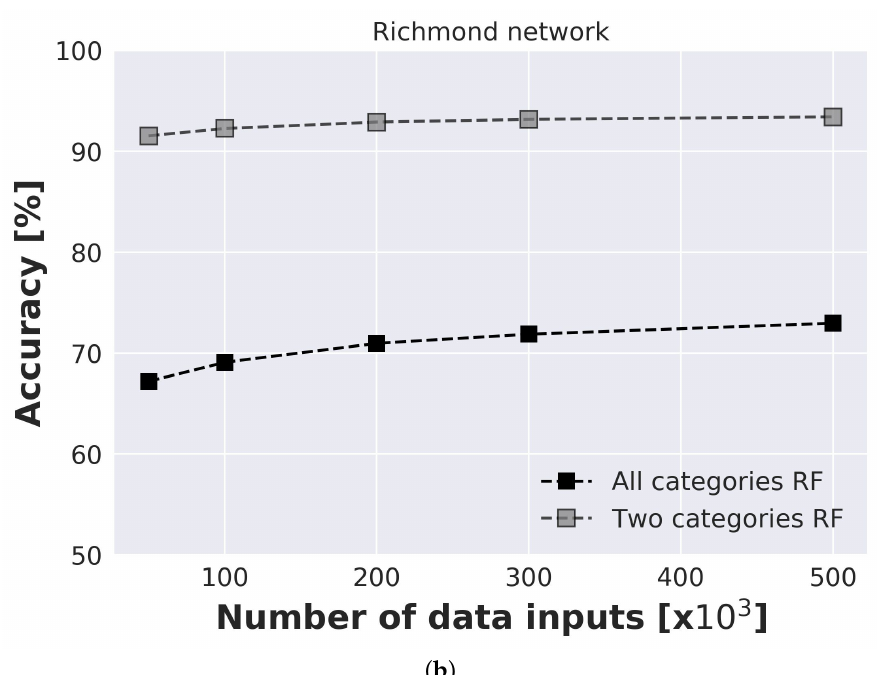
Figure 6. Accuracy of prediction models for different number of inputs for ( a ) Net3 network and ( b ) Richmond